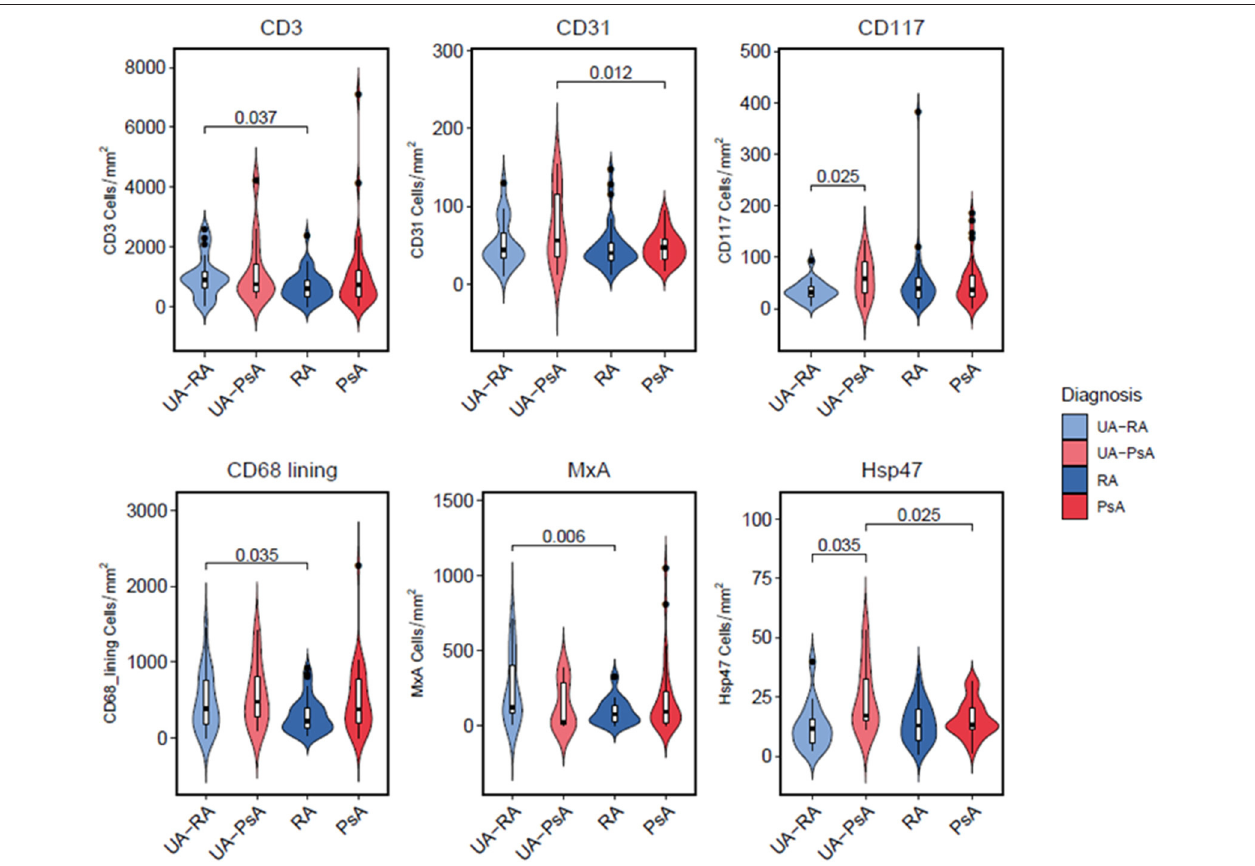
FIGURE 2 | Characterization of cellular patterns by patient group. Violin plots depicting density distributions of positive cells (in area = 1 mm 2 ), stained with surface protein antibodies and analyzed by immunohistochemitry. Inner boxplots show median, interquartile range, minimum and maximum values of every analyzed surface marker. Undifferentiated Arthitis (UA-RA, UA-PsA) and definite Rheumatoid Arthritis (RA) and Psoriatic Arthritis (PsA) using ANOVA-test, p -values between different groups are depicted for each marker.